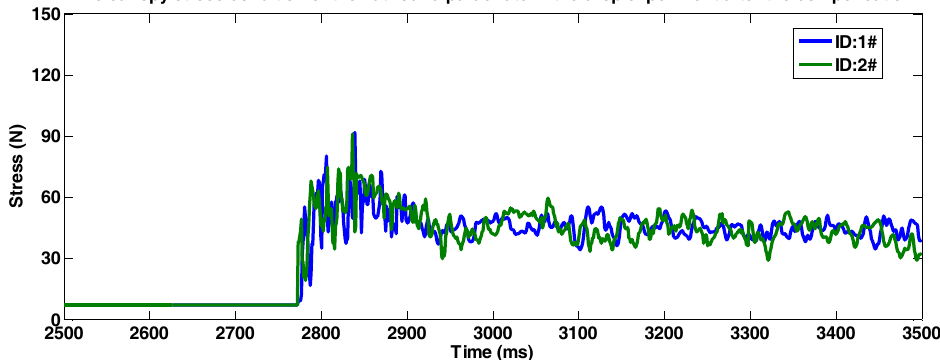
Figure 7. The canopy stress condition of the flat round parachute after the compensation.